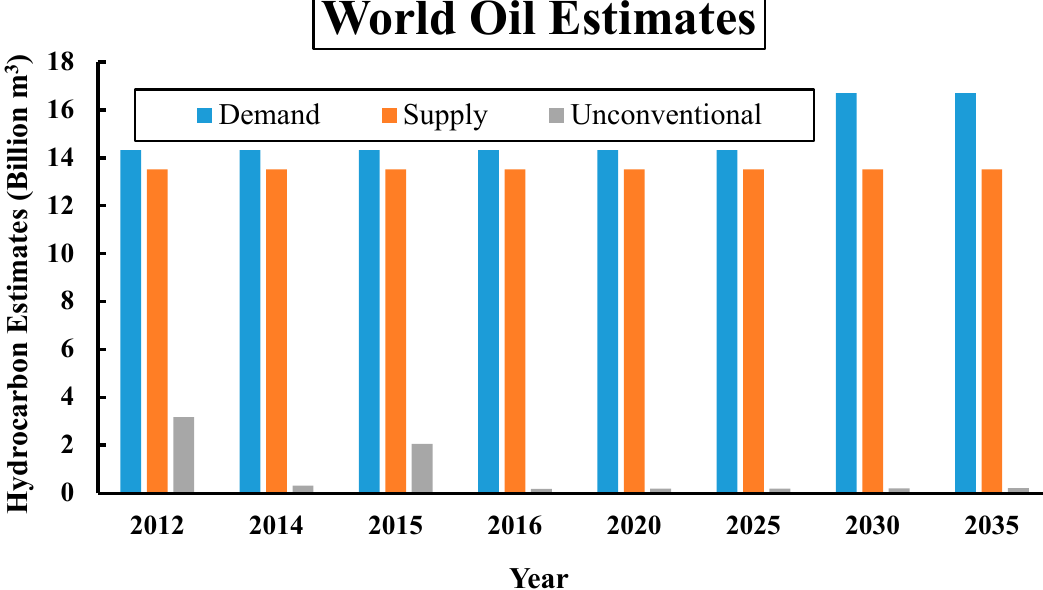
Figure 1. World oil demand, supply and contribution of unconventional oil, adapted from [82].